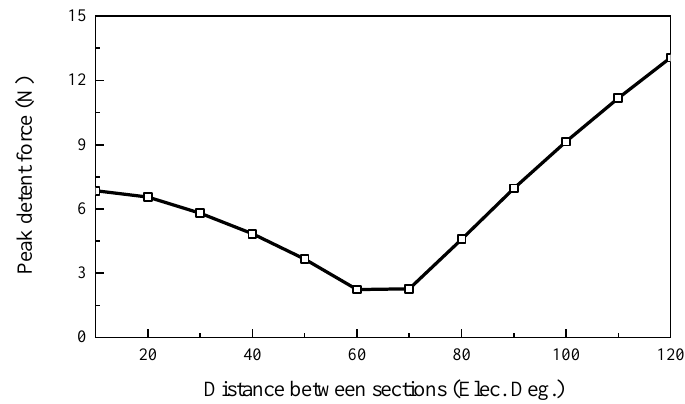
Figure 7. Detent force of Model 3: ( a ) detent force waveforms by sections; ( b ) detent force frequency decomposition.